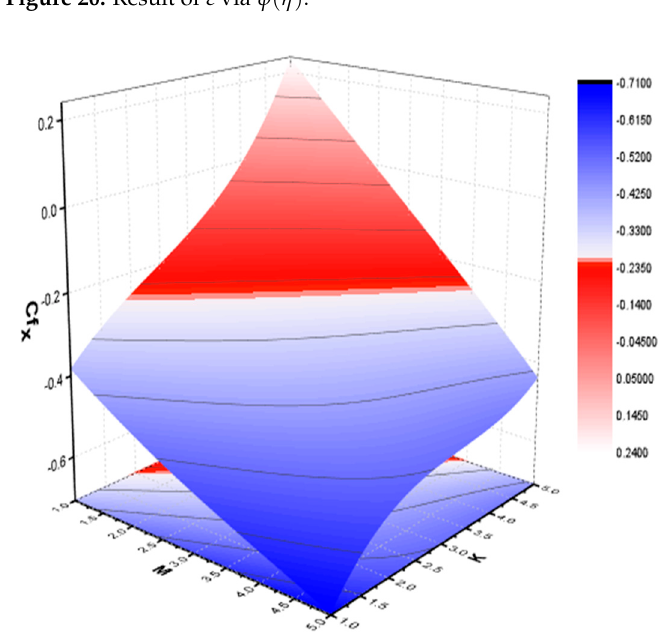
( ) ϕ η ε ( ) ϕ η via . ε ( ) ϕ η via . ε via .